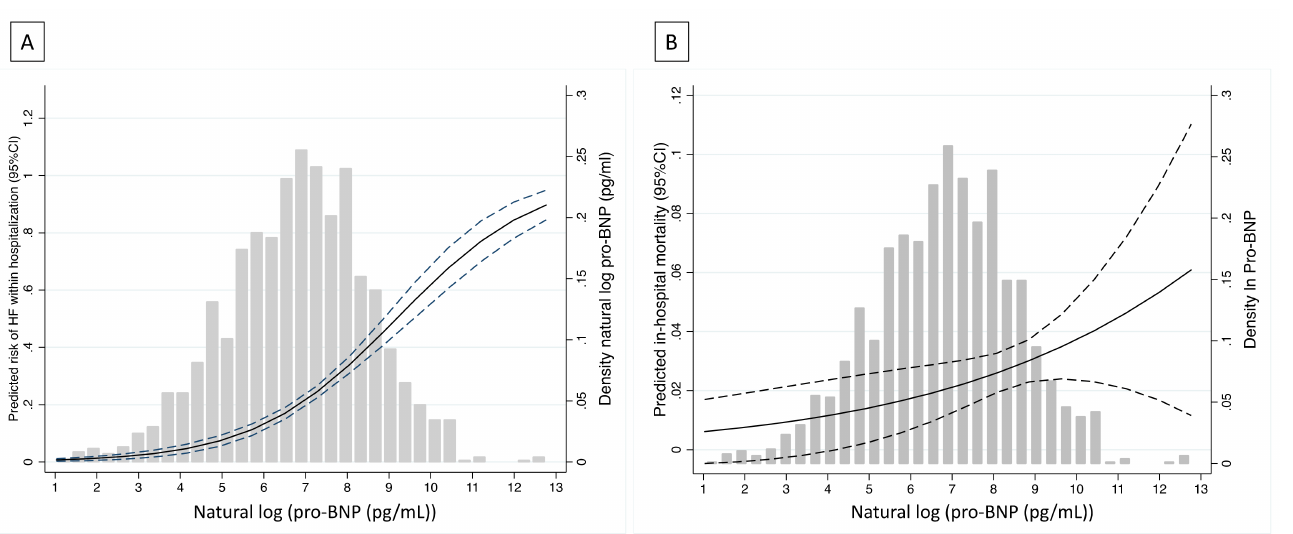
Figure 1. Histograms for pro-BNP distribution (density) and predicted risk of in-hospital heart failure ( A ) or death ( B